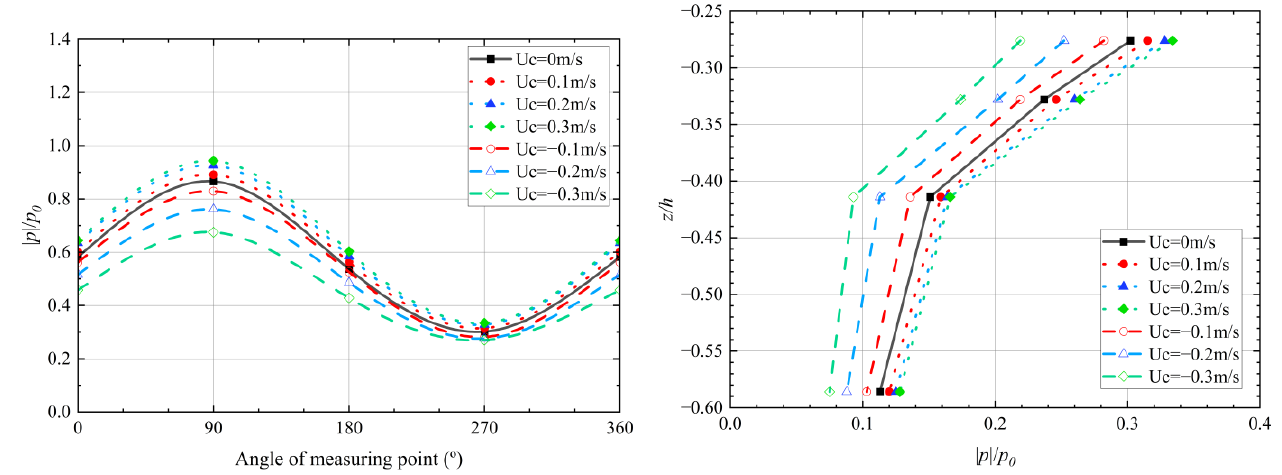
Figure 9. Variation of the dimensionless pore pressure amplitude around the pipeline under different current conditions within the fine sand seabed.